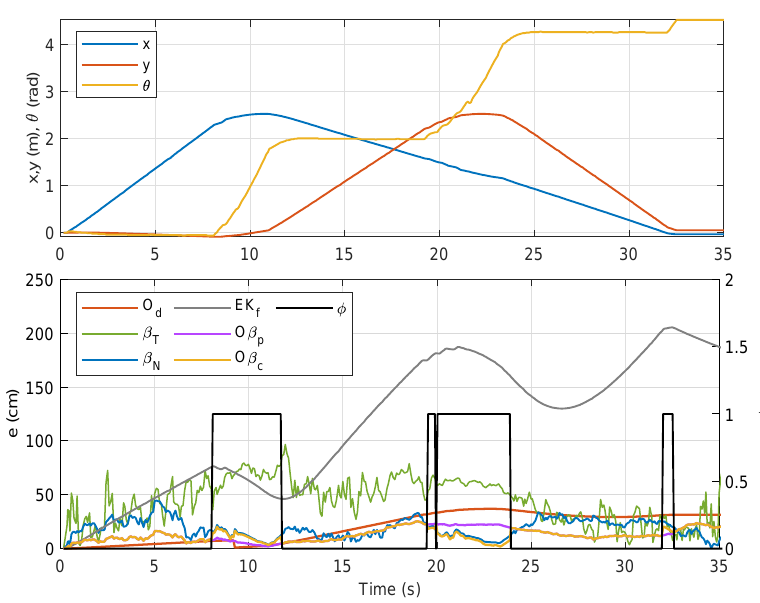
Figure 15. Trajectory 2: Position of NSBot2 in terms of x , y and θ based on odometry ( top ); and temporal localization-error analysis ( bottom ).